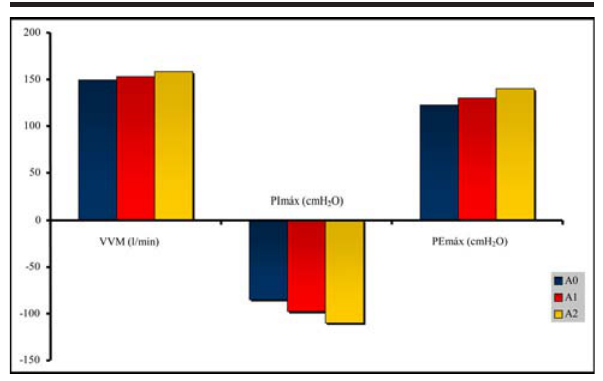
FIGURE 7 - Diagram representing the means of variable (MVV), and medians of variables PImax and PEmax at evaluations 0, 1 and